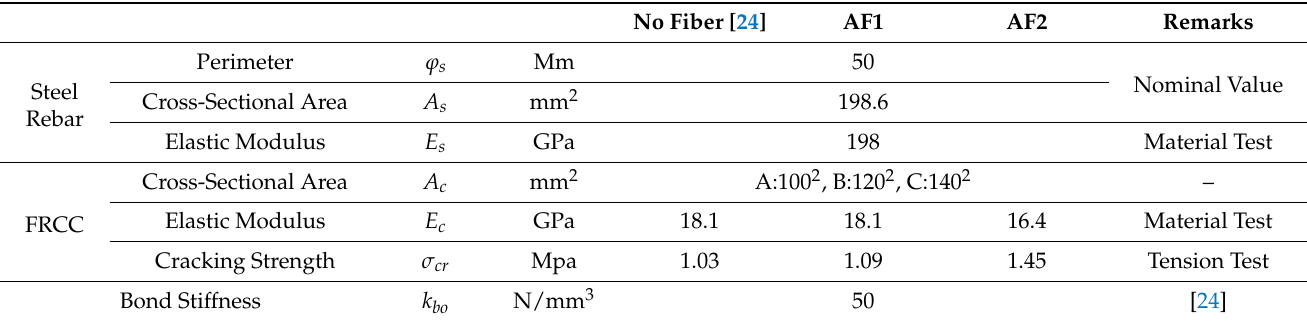
Table 5. Parameters adapted for theoretical formula.